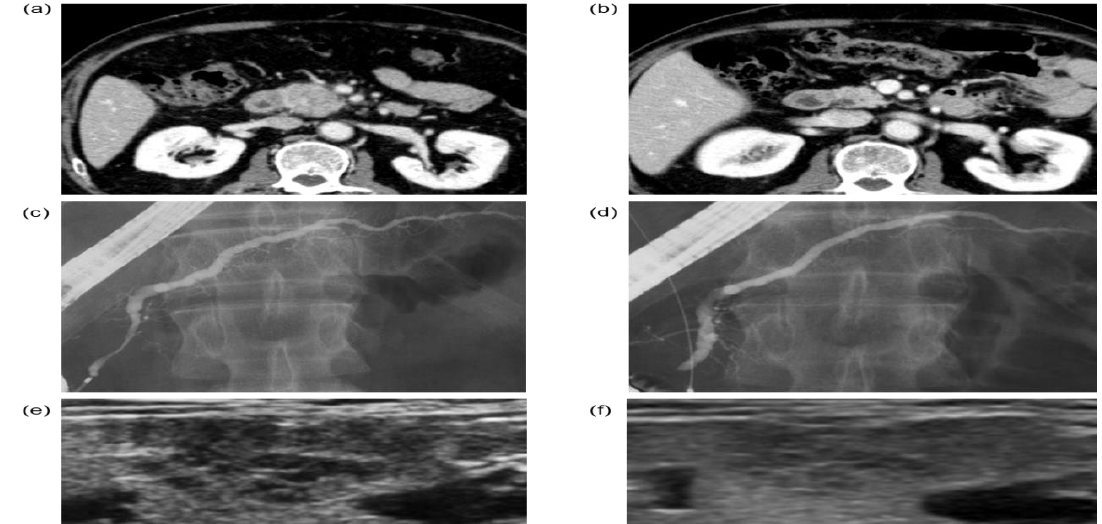
Figure 3. A representative case in which a definitive diagnosis of AIP was established using the presence of multiple hypoechoic nodules indicative of sialadenitis before a steroid trial. CT findings before ( a ) and after ( b ) the steroid trial. Endoscopic retrograde cholangiopancreatography findings before ( c ) and after ( d ) the steroid trial. Sialadenitis could not be diagnosed using palpation in this case; however, ultrasonographic findings of multiple hypoechoic nodules were observed before steroid therapy ( e ), which became obscured after steroid therapy ( f ).